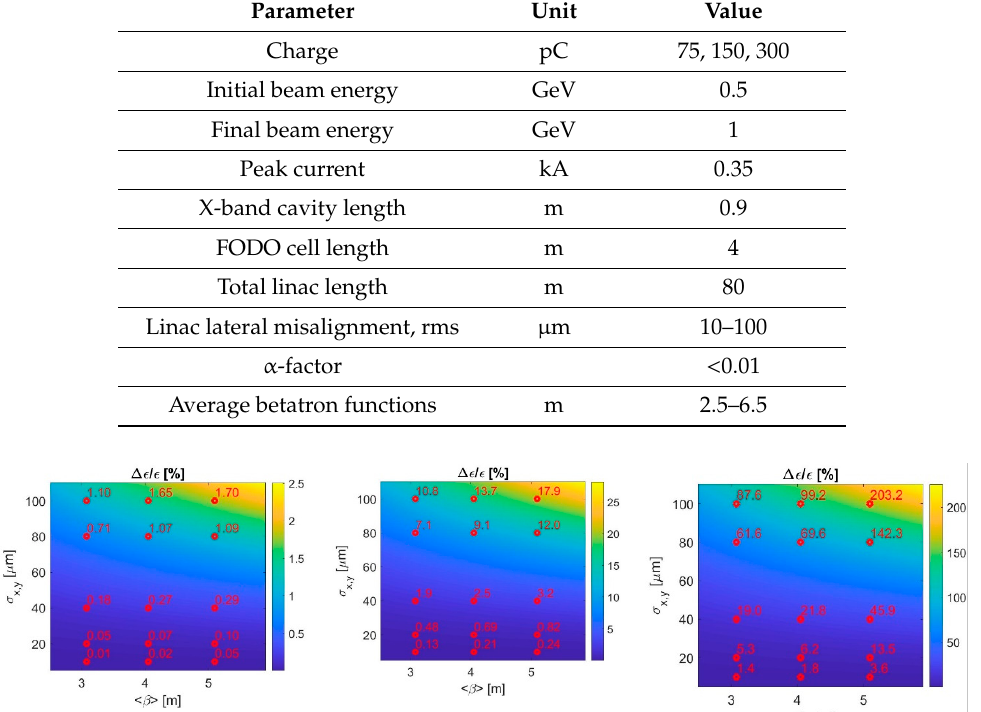
Table 5. CompactLight linac parameters for the evaluation of the BBU instability. For other beam parameters at the various bunch charges, see Table 3.